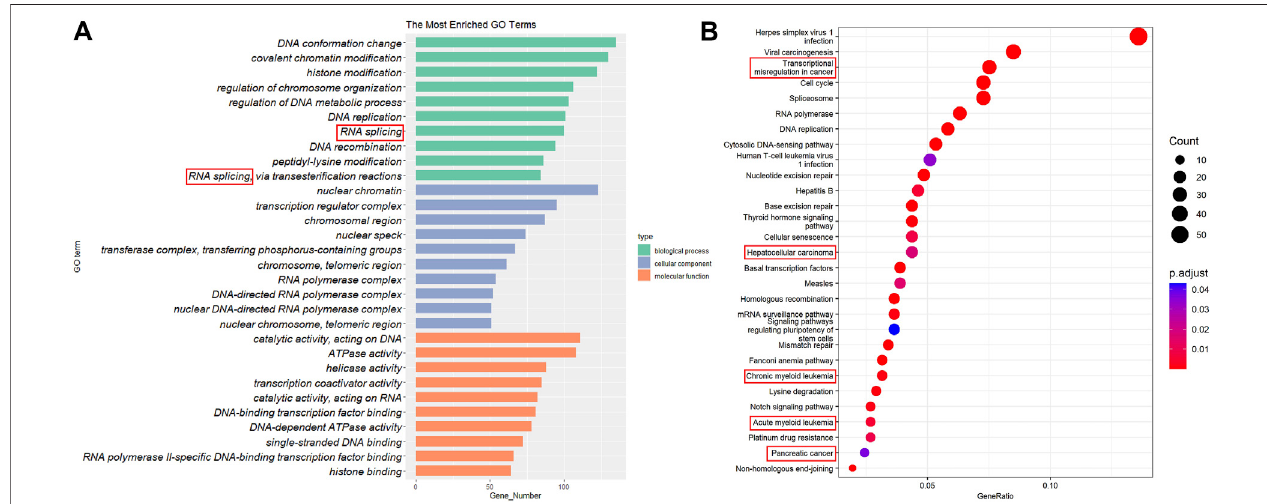
FIGURE 2 | Gene Ontology (GO) annotation and Kyoto Encyclopedia of Genes and Genomes (KEGG) pathway enrichment analysis. (A) The top 20 GO terms in biological process, cellular components, and molecular functions. (B) The top 29 KEGG pathways.